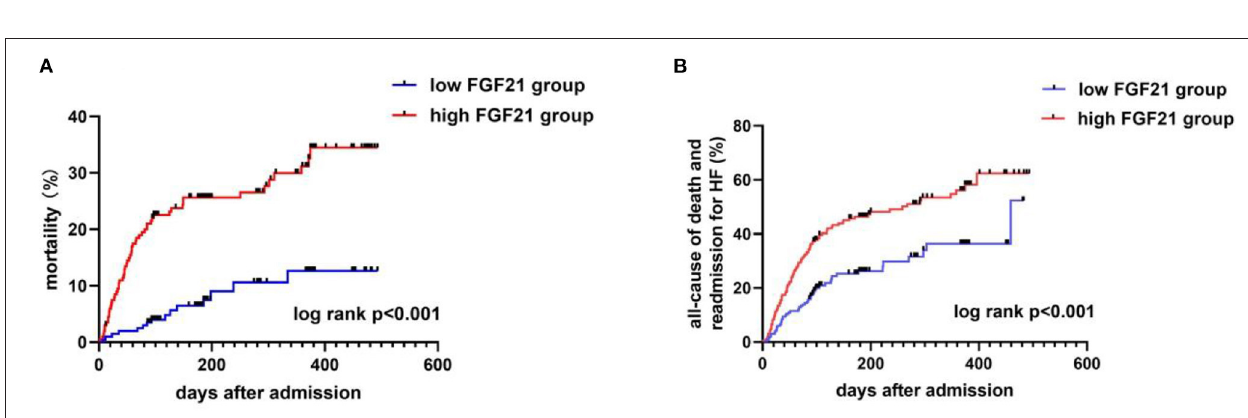
with a high fat, low carbohydrate ketogenic diet (22). In addition, serum FGF21 concentrations are increased in patients with non- alcoholic fatty liver disease, and are positively correlated with